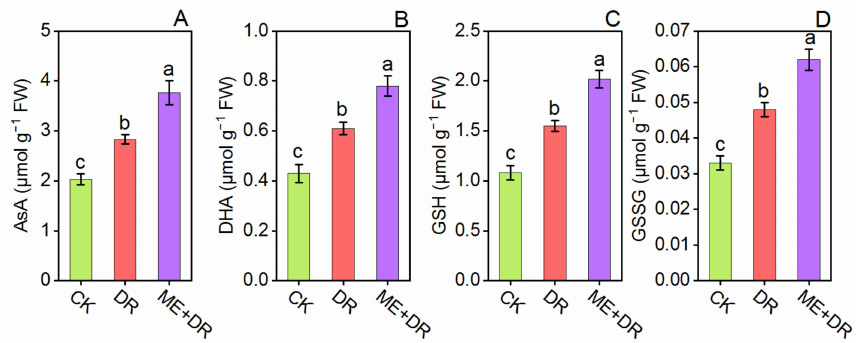
Figure 10. Exogenous supplementation of melatonin promoted non-enzymatic antioxidant [AsA ( A ), DHA ( B ), GSH ( C ), and GSSG ( D )] system of tomato seedlings under drought stress conditions. Means ± standard error, n = 3, significant difference is exhibited by lowercase letters ( p ≤ 0.05), according to LSD